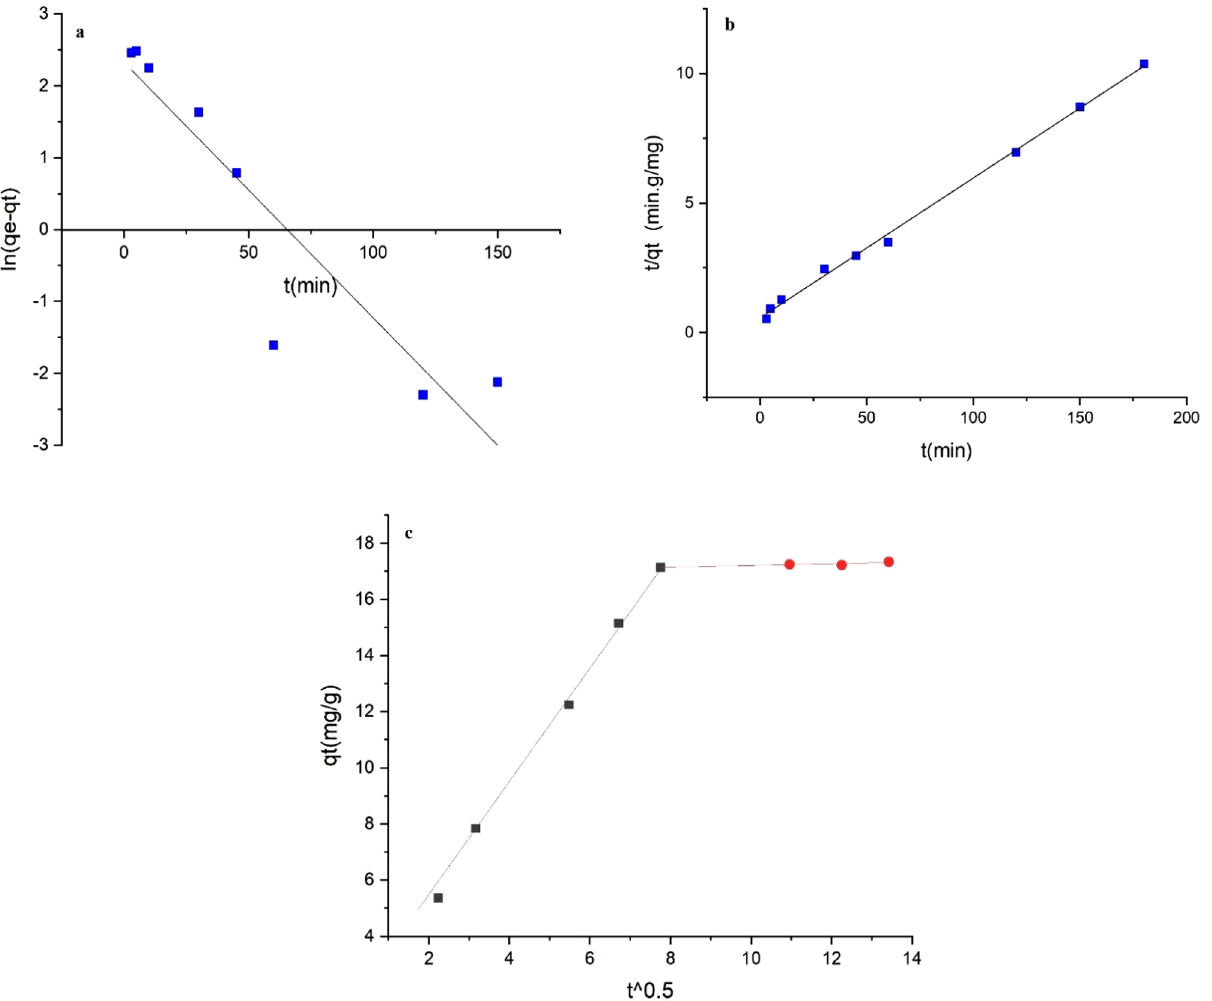
Figure 13. ( a ) Pseudo first-order kinetic, ( b ) pseudo second-order kinetic, ( c ) intr-aparticle diffusion model [(pH of 6, Pb(II) concentration (20 ppm), contact time range of (5–180 min), volume of the solution (40 ml), adsorbent dosage (0.04 g), and temperature range of (298 K)].